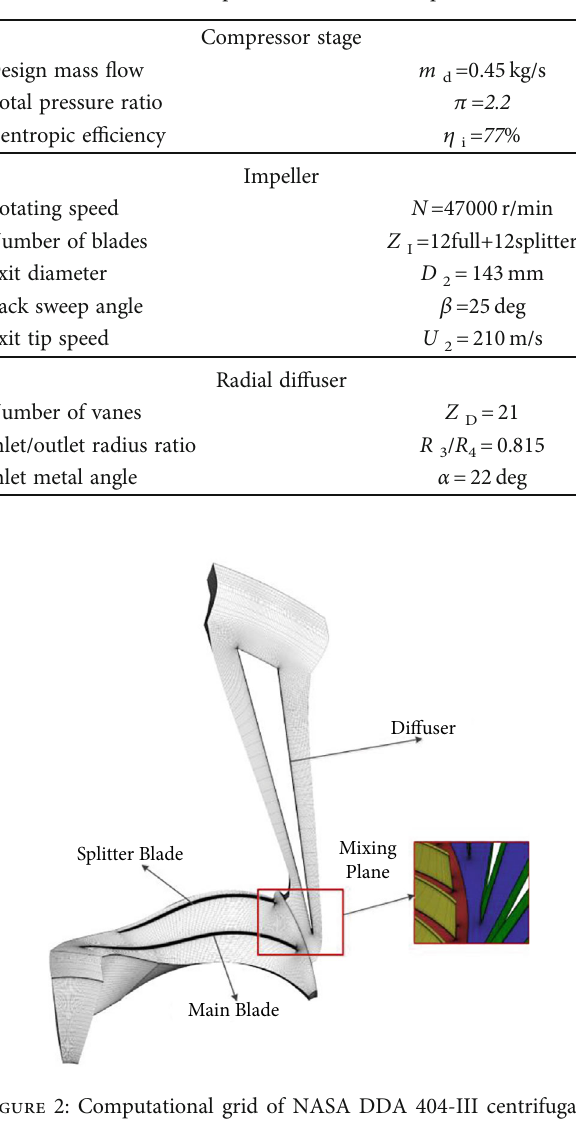
Table 3: Case of pressure ratio 2.2 Compressor.